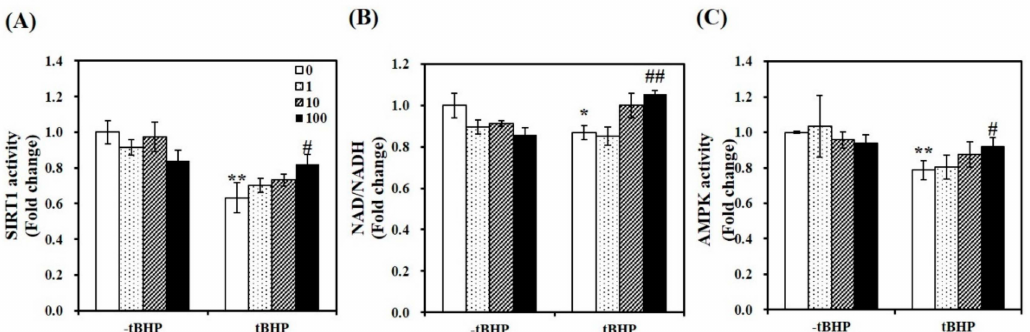
Figure 4. E ff ects of 1,25-dihydroxyvitamin D (1,25(OH)2D) on AMP-activated protein kinase (AMPK) / sirtulin 1 (SIRT1) activities and the ratio of nicotinamide adenine dinucleotide (NAD) to NADH. AMPK activity ( A ), SIRT1 activation ( B ), and NAD / NADH ( C ) were analyzed by commercial kits, normalized to their relative protein levels, and expressed as the fold change compared to vehicle control. The value of each bar represents mean ± SEM. Experiments represent at least two or three independent experiments ( n = 8–10 per group). * p < 0.05, ** p < 0.01 compared to vehicle control. # p < 0.05, ## p < 0.01 compared to tBHP